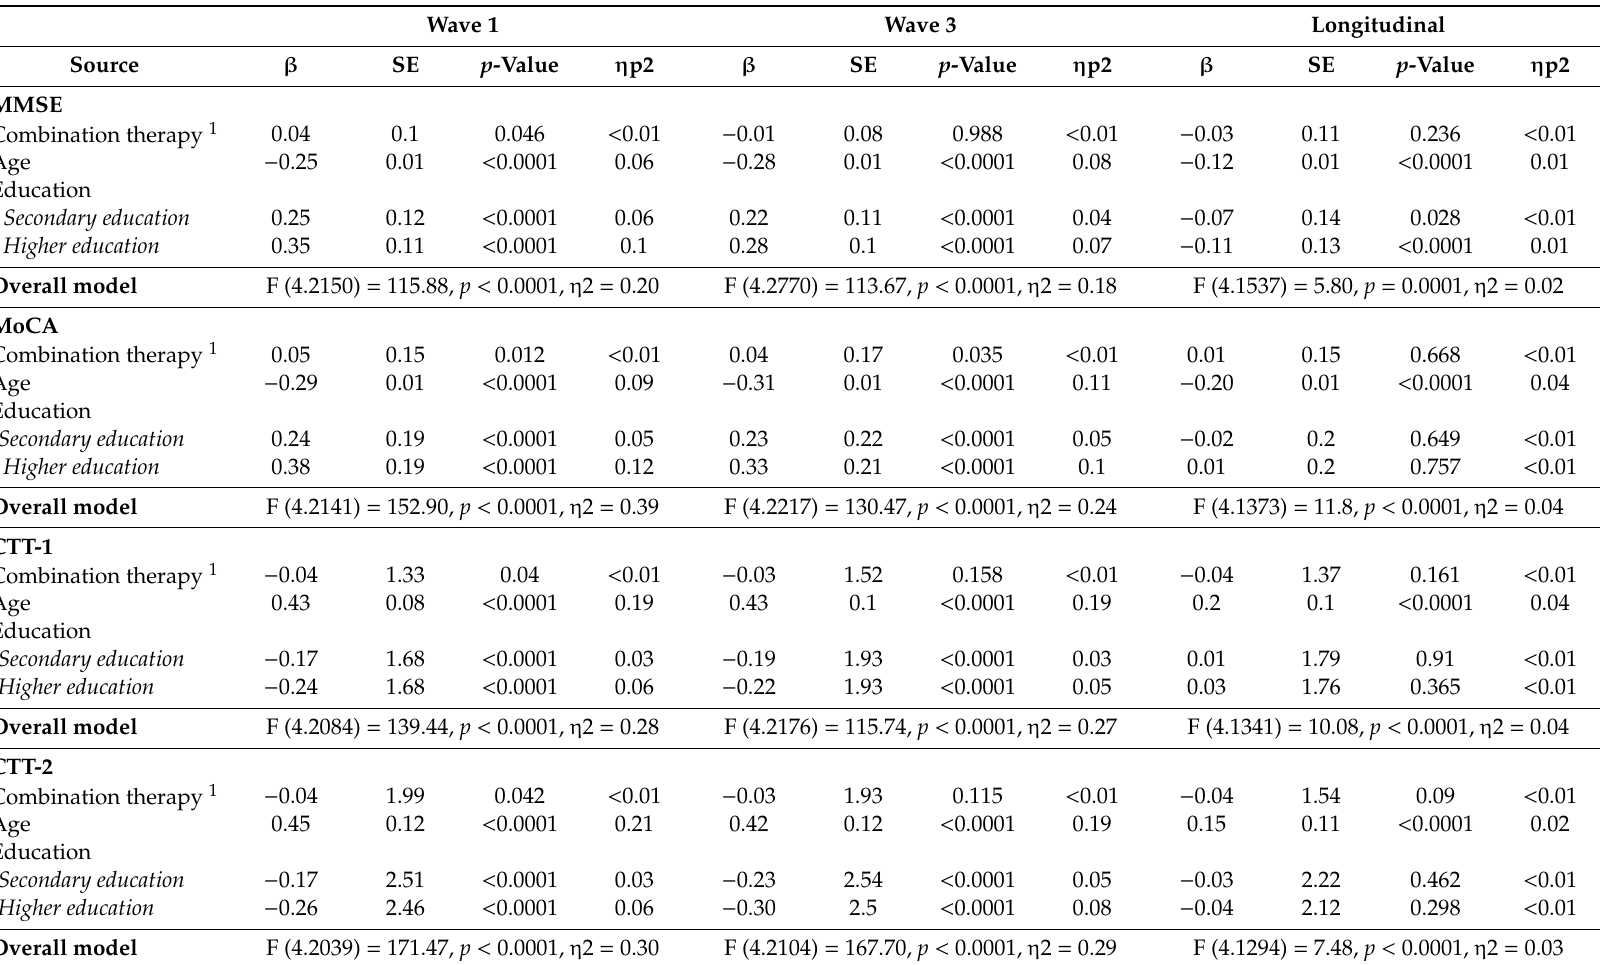
Table 5. Multivariate regression results of the e ff ects of medication status on di ff erent cognitive measures controlling for age and education. Wave 1 Wave 3 Longitudinal